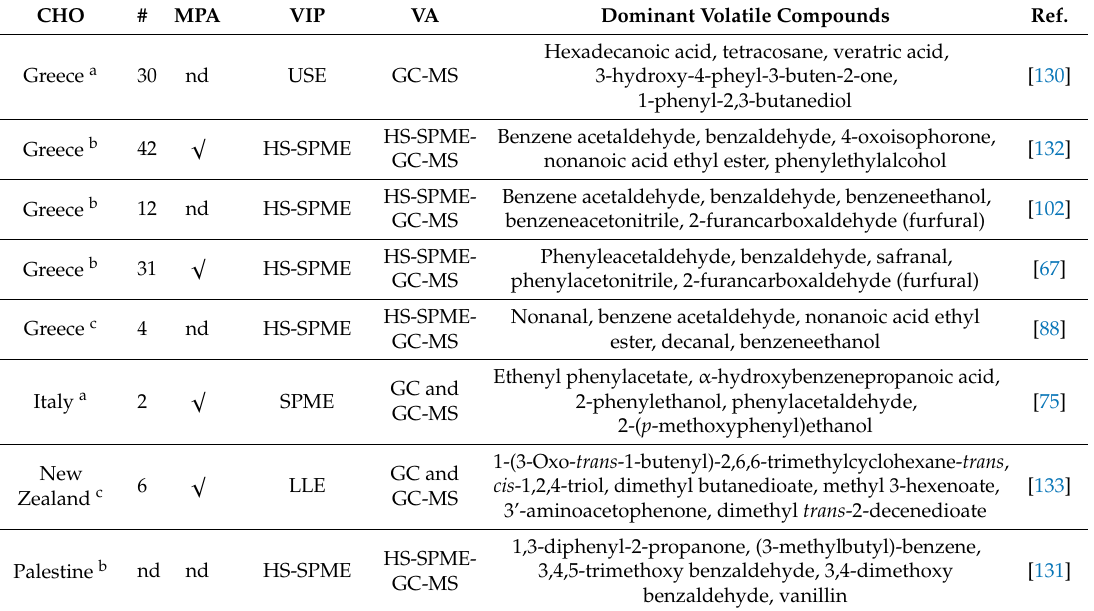
Table 21. Thyme honey’s main volatiles, with reference to the country of origin, number of samples, isolation and analysis procedures and five main volatile components. Unless otherwise specified, the honeybee type was A. mellifera